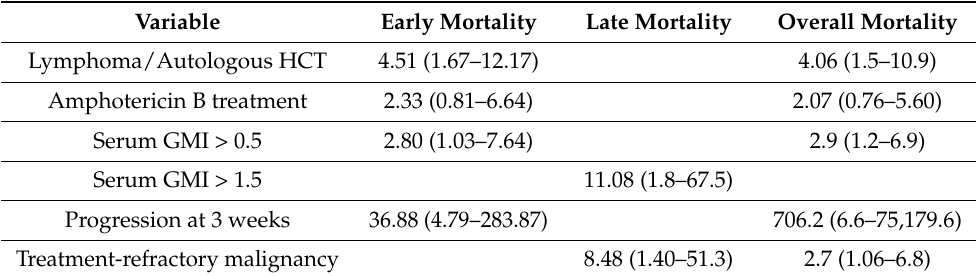
Table 2. Cox regression models for early, late, and overall